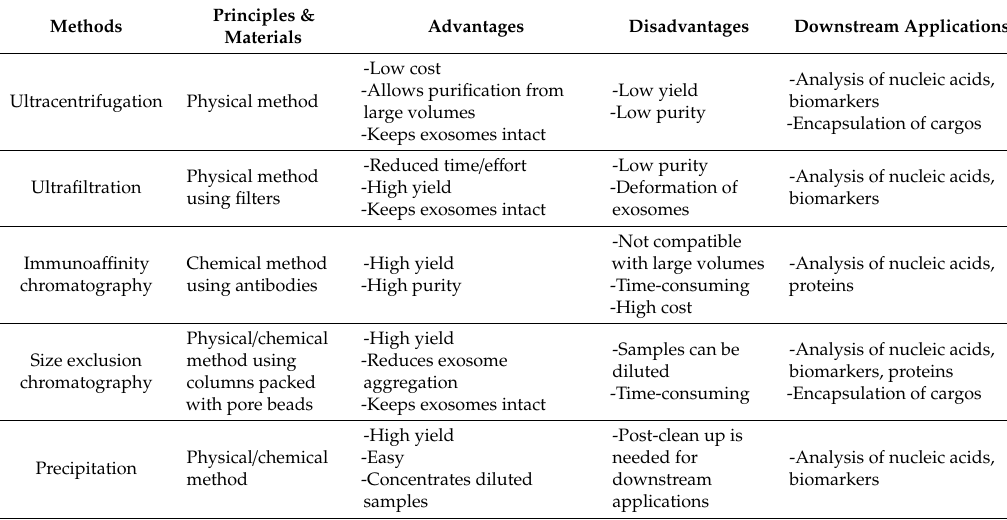
Table 1. Summary of exosome isolation